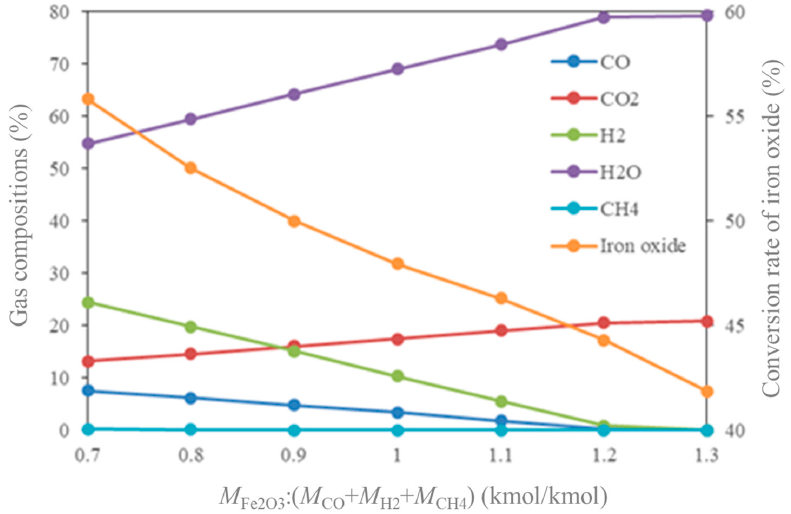
Figure 10. Influence of M Fe2O3 /( M CO + M H2 + M CH4 ) on gas compositions and conversion rate of iron oxide.